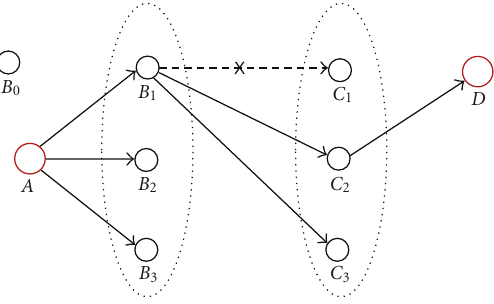
Figure 1: Opportunistic Routing on ad-hoc